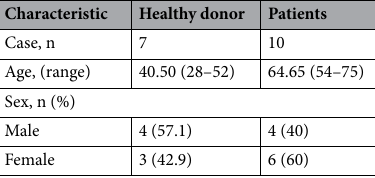
Table 1. Characteristics of the subjects enrolled in the study of